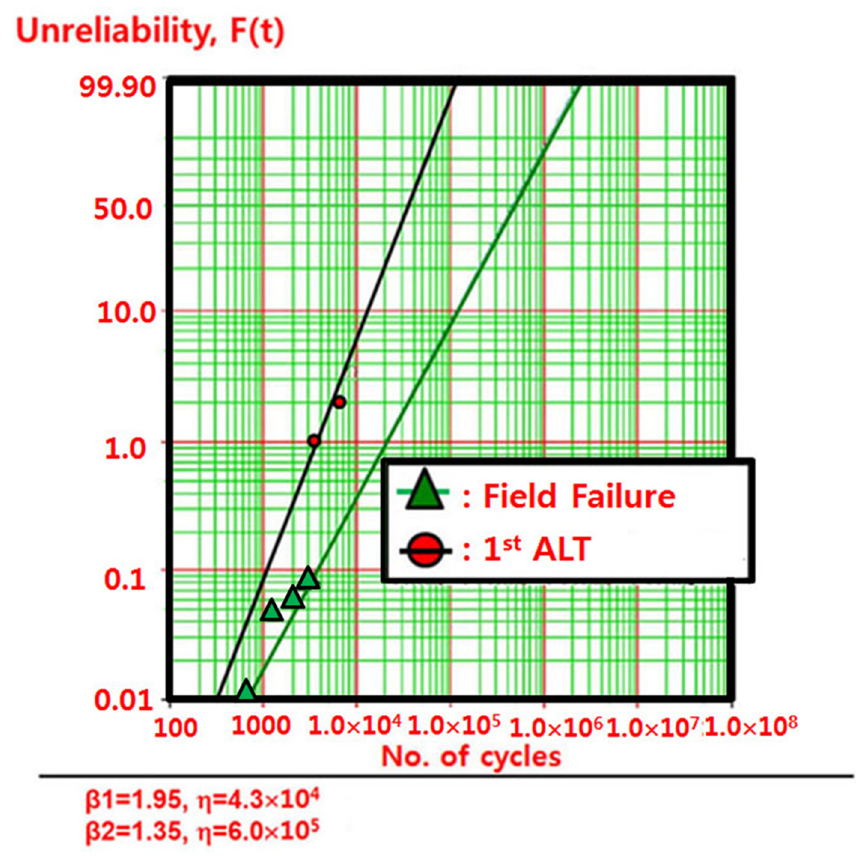
Figure 11. Market statistics and consequences of ALT on Weibull chart.